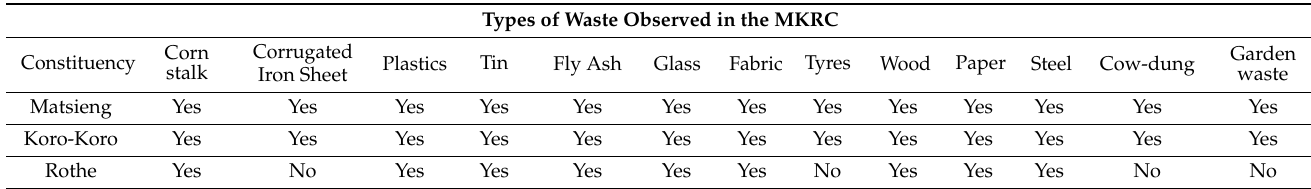
Table 5. The illustration of types of waste observed in the MKRC by